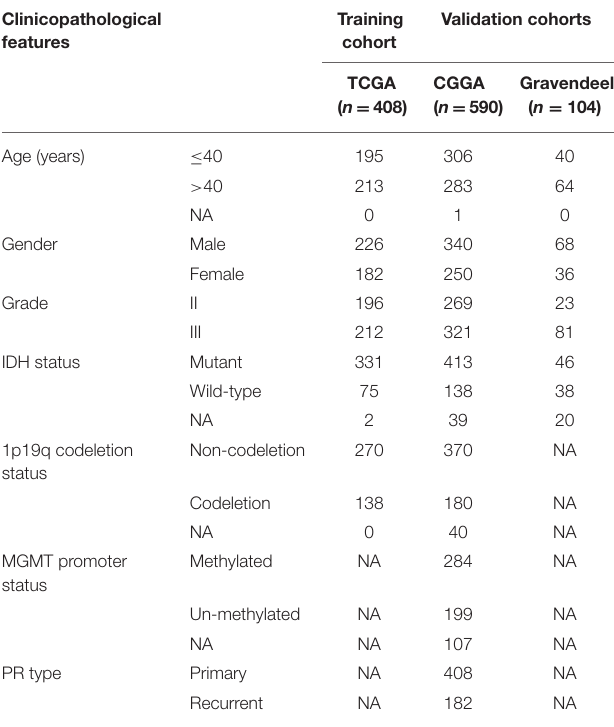
TABLE 1 | Clinicopathological information of patients with lower-grade glioma (LGG) in the training and validation cohorts. Clinicopathological